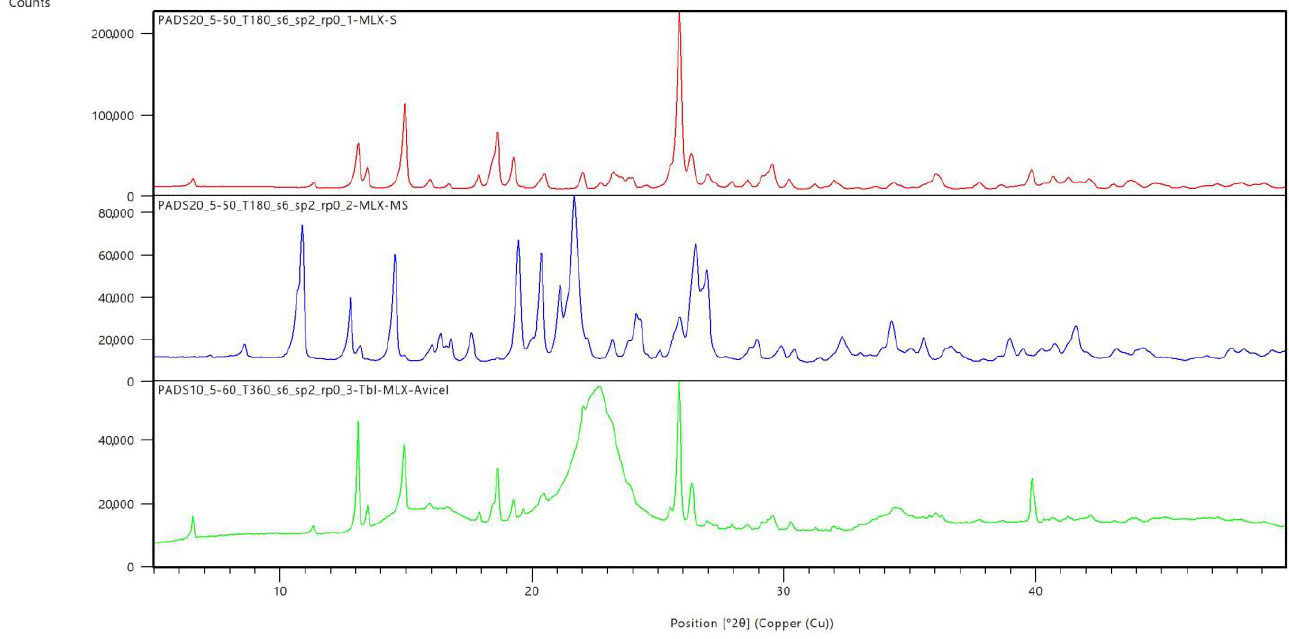
Figure 10. XRPD pattern of MX polymorphic form I ( top ), polymorphic form III ( middle ), and MCC tablet impregnated by MX ( bottom ).